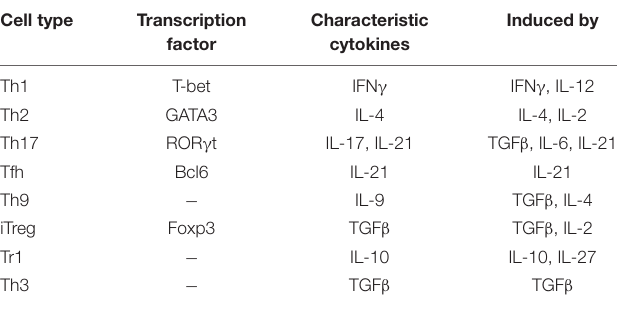
TABLE 1 | CD4 + T cell types, their associated transcription factors, characteristic cytokines, and exogenous cytokines that induce the cell type. Cell